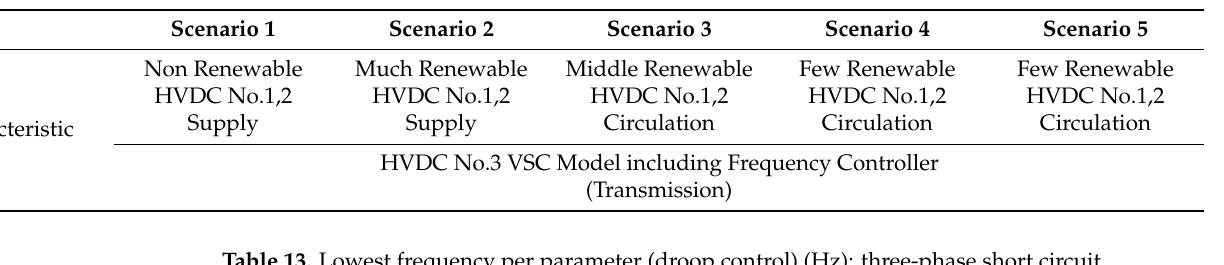
Table 13. Lowest frequency per parameter (droop control) (Hz): three-phase short circuit.